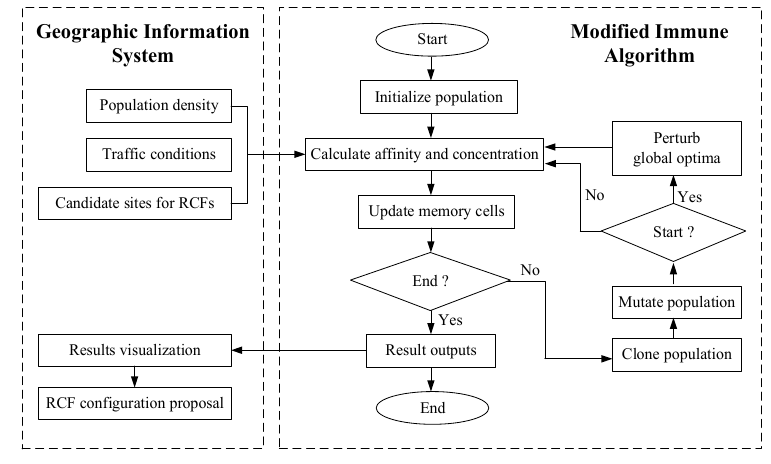
Figure 1. The framework of integrating modified immune algorithm (MIA) and geographic information system